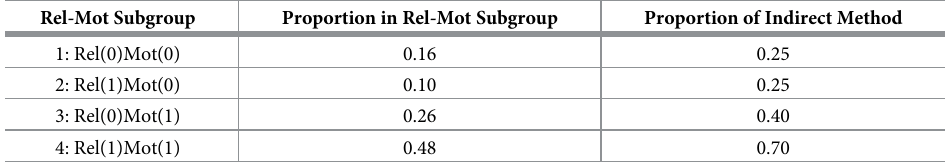
Table 12. Proportions used for simulations of population in each Rel-Mot†subgroup and method of abuse.